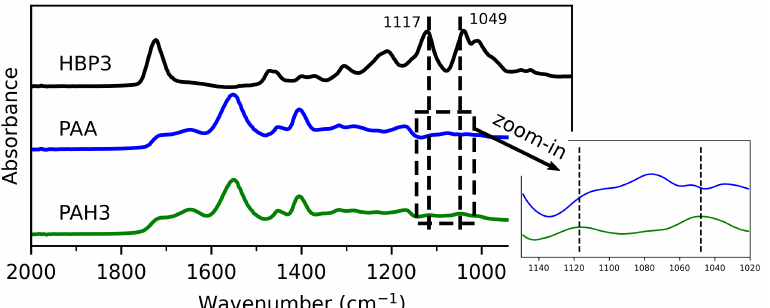
Figure 4. FTIR absorption spectra of the HBP3 powder (black), freeze-dried PAA hydrogel (blue), and freeze-dried PAH3 hydrogel (20 wt% HBP3) (green), between 2000 and 800 cm − 1 . All the spectra were individually normalised by using the highest peak absorption of each material. Inset: zoom-in plot showing two new emerged peaks in the spectra of the PAH3 hydrogel, relative to the PAA hydrogel.